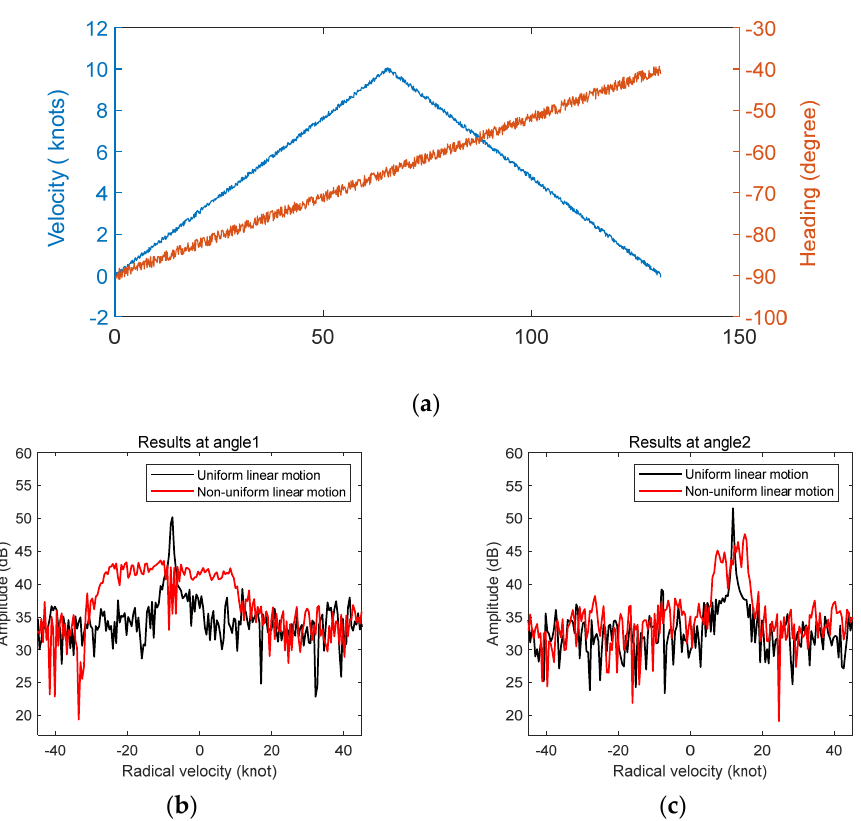
Figure 10. Simulation results when both heading and velocity of ship change: ( a ) the distribution of the velocity and heading of the platform, ( b ) beam results of target 1 at angle1, ( c ) beam results of target 2 at angle2.